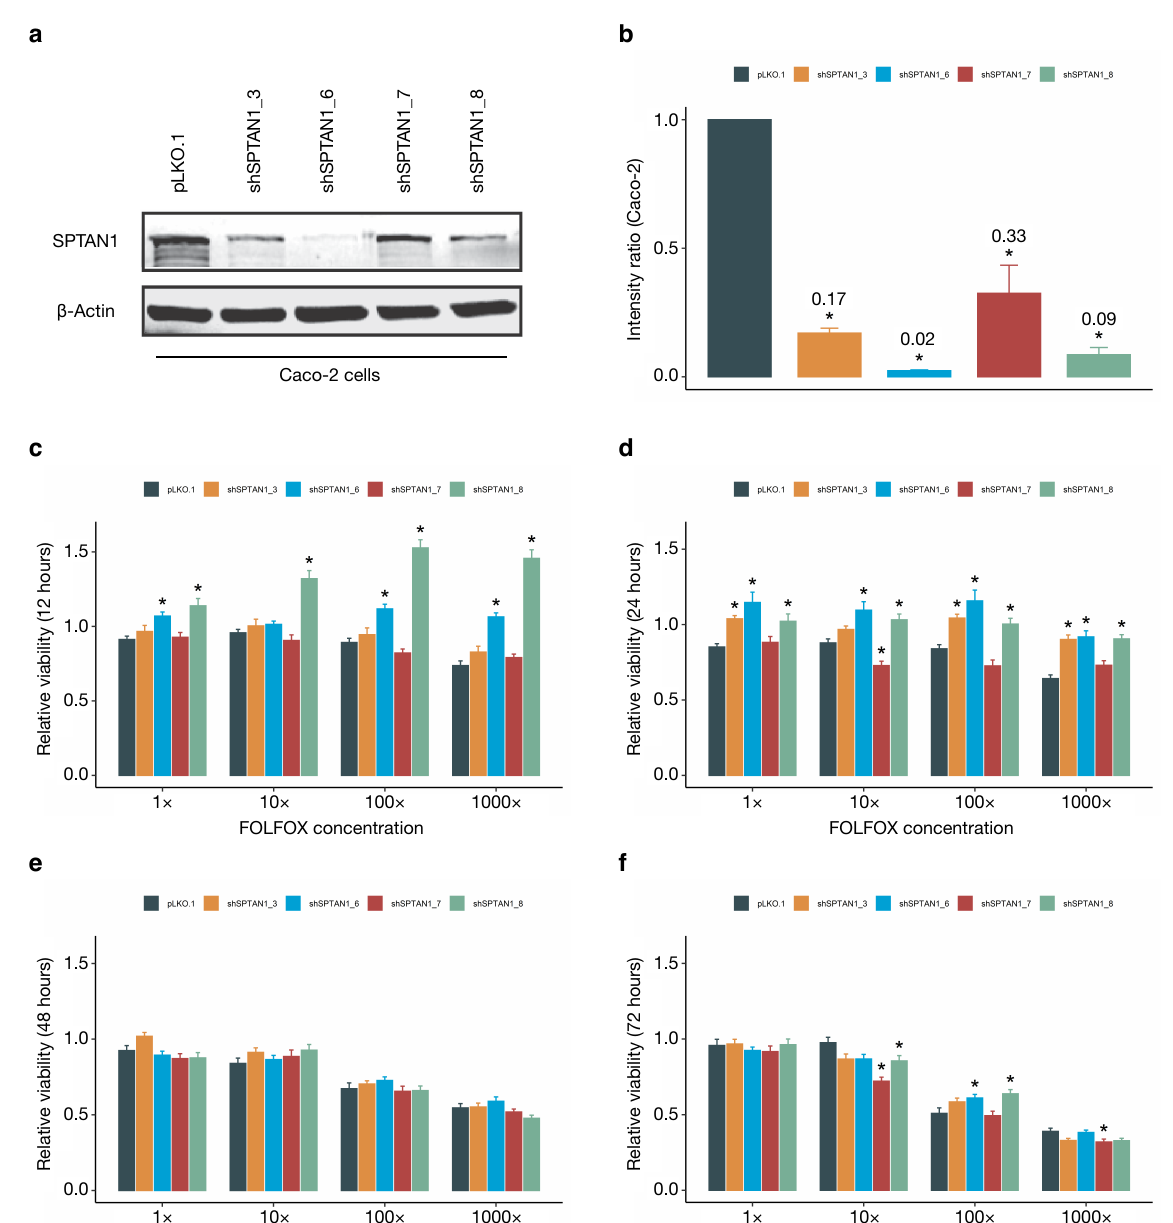
Figure A2. Caco-2 cells with SPTAN1 knockdown are less responsive to FOLFOX chemotherapy. Short hairpin RNAs were used to knock down SPTAN1 expression in Caco-2 colon cancer cells ( a ). Western blot band intensities were quantified by digital image analysis, to determine SPTAN1 protein levels of knockdown cells relative to control-transduced cells (denoted pLKO.1) ( b ). Bar charts illustrating the response to FOLFOX chemotherapy in Caco-2 colon cancer cells with stable knockdown of SPTAN1 expression ( c – f ). Cell viability in response to incremental doses of FOLFOX chemotherapy was measured by tetrazolium dye (MTT) colorimetric assay after ( c ) 12 h, ( d ) 24 h, ( e ) 48 h, and ( f ) 72 h. Data represent averages from three independent experiments, totalling up to 48 individual absorbance readings for each combination of knockdown strain, timepoint and chemotherapy dose. Absorbance readings of FOLFOX-treated cells were normalised to the average absorbance values of the respective control-treated cells. SPTAN1 knockdown cells and control-transduced cells (denoted pLKO.1) were compared by one-way ANOVA. Differences between individual knockdown strains and the reference group (control-transduced cells) were assessed by Dunnett’s post-hoc test, and denoted with an asterisk (*) if they reached statistical significance. Results with a p -value < 0.05 were considered statistically